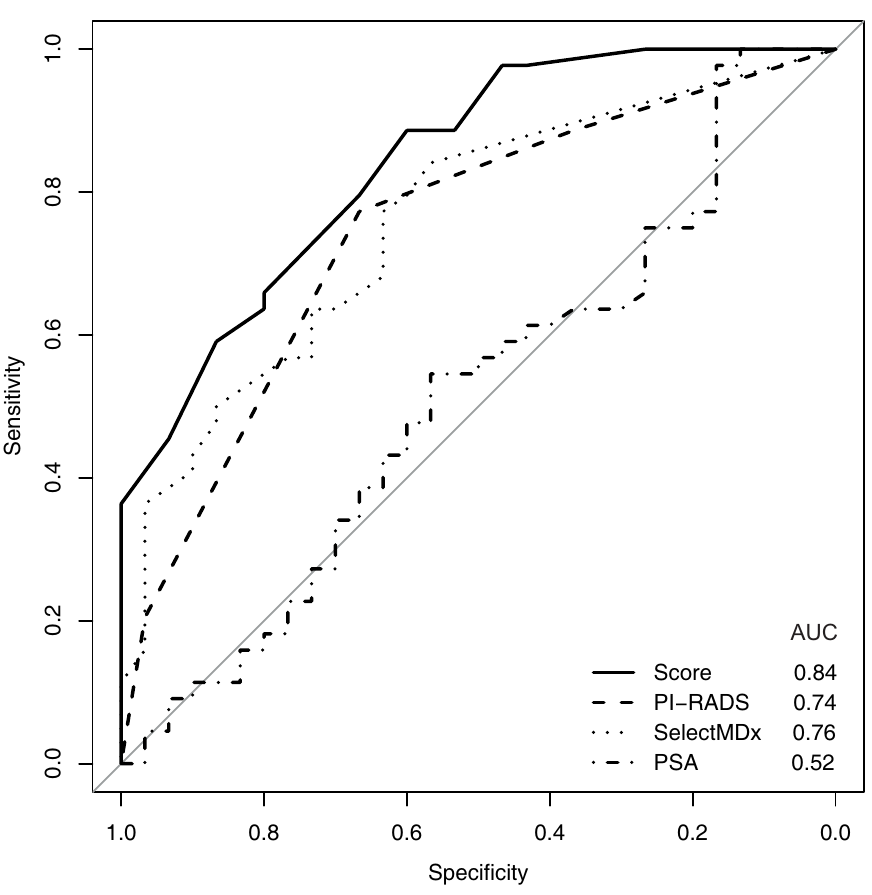
Fig 4. ROC curve for PI-RADS, SelectMDx 1 urine test marker, PSA and the novel scoring system (combination of PI-RADS, history of prior biopsy and SelectMDx 1 ).